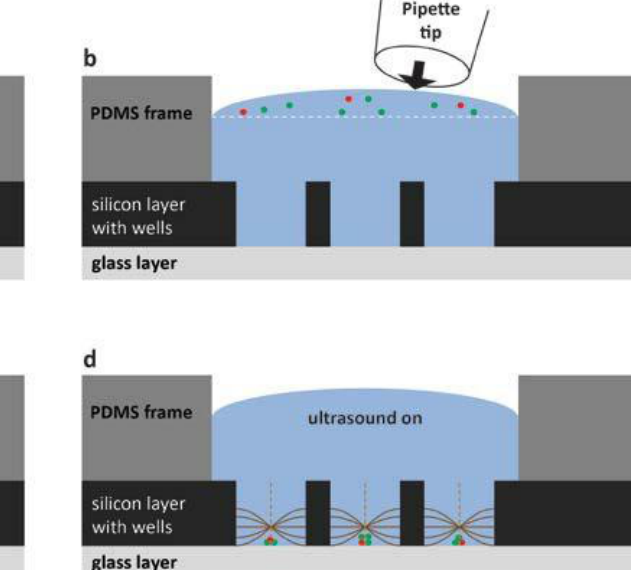
Figure 5. Schematic illustration (not to scale) of the different steps of the cell handling method. For simplicity, only three out of a hundred wells are shown (vertical cross-section view), and only the PDMS frame and the multi-well microplate (item #4 and #5 in Figure 2). ( a ) The microplate is first primed with cell medium shown in blue; ( b ) The cell suspension is added as a small drop from a pipette tip; ( c ) Cells sediment by gravity down into the wells. The average number of cells per well is controlled by the cell concentration in the added drop in ( b ). In this example, there is on average 1 red cell and 2.33 green cells per well; ( d ) When ultrasound is turned on according to the procedure described in Figure 3, cells are trapped, aggregated and centrally positioned in each